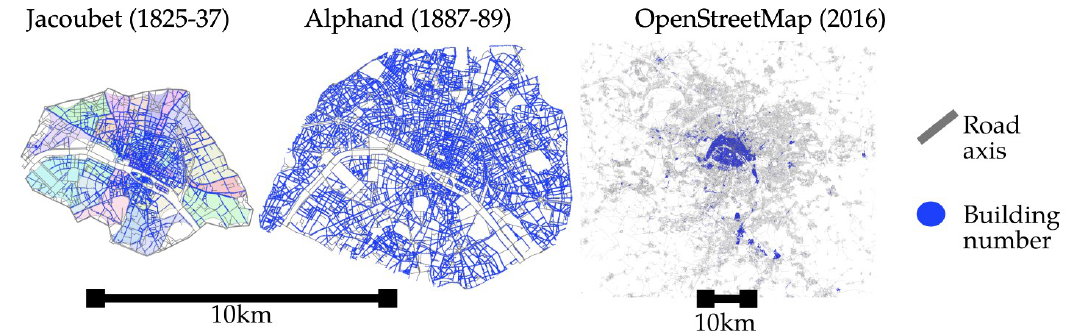
Figure 10. An overview of some of the geohistorical objects used for geocoding. These were mostly extracted manually, often collaboratively, using various